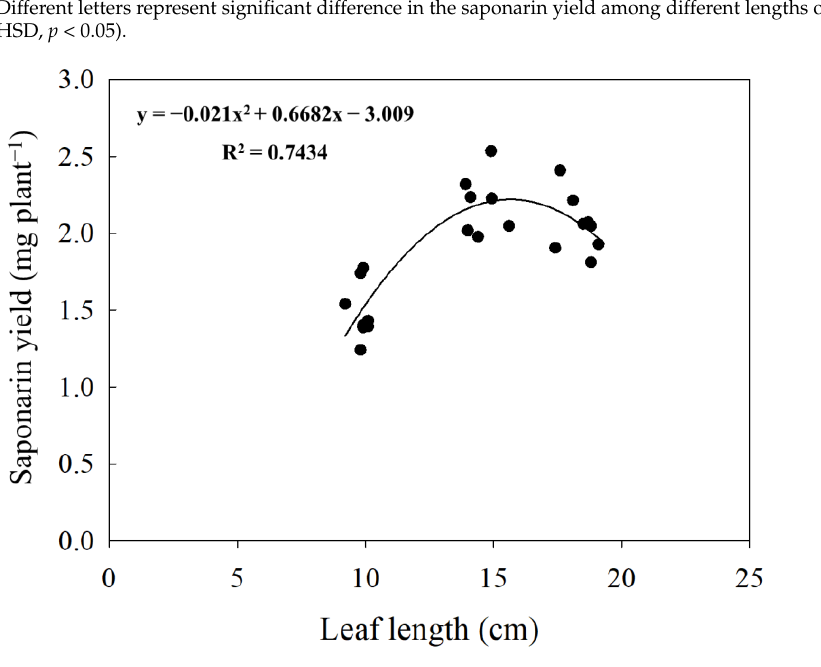
Figure 3. Polynomial relationship between sprout length and saponarin yield ( n = 36). Black dots indicate the saponarin yield of barley sprouts cultivated with different sowing times in 2019 and 2020. The peak value of saponarin yield in this study was discovered from the sprouts of 15.9 cm length.